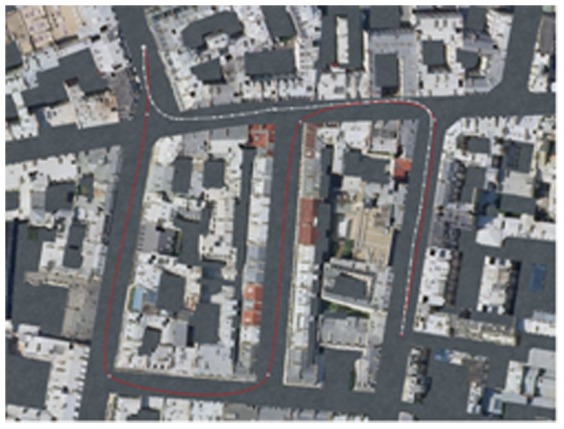
Example (from survey perspective) of a path from the encoding condition (in red) and of a correct shortcut that a subject produced for the same path (in white).